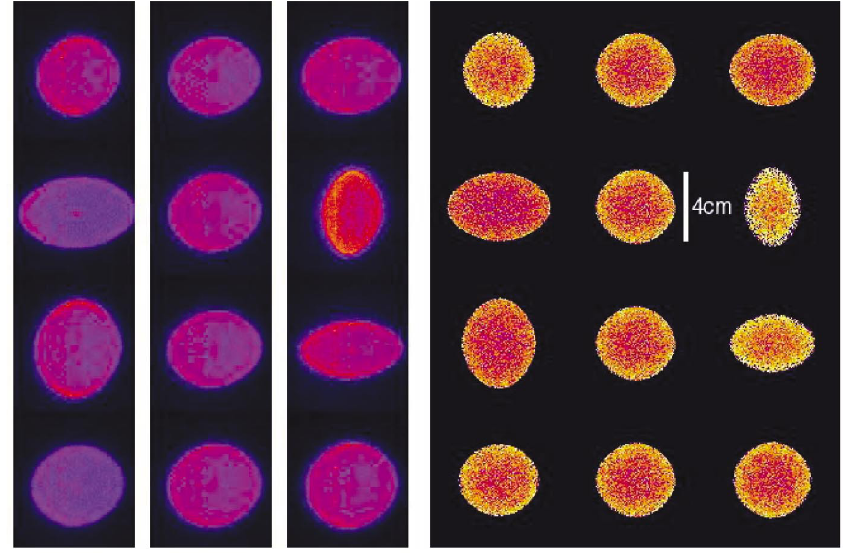
FIG. 9. (Color) Numerical results and camera images of beam profiles as a function of quadrupole field